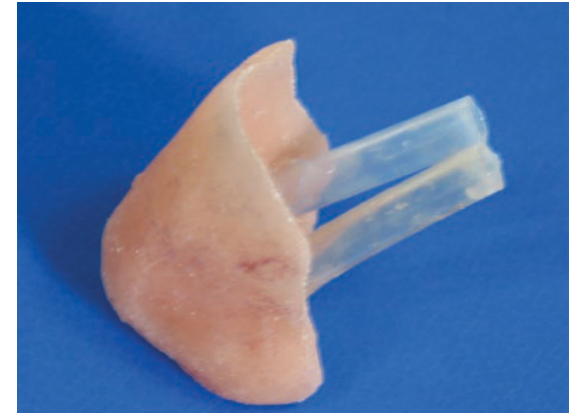
Figure 4. Appearance of nasal prosthesis with retainer from lateral side.